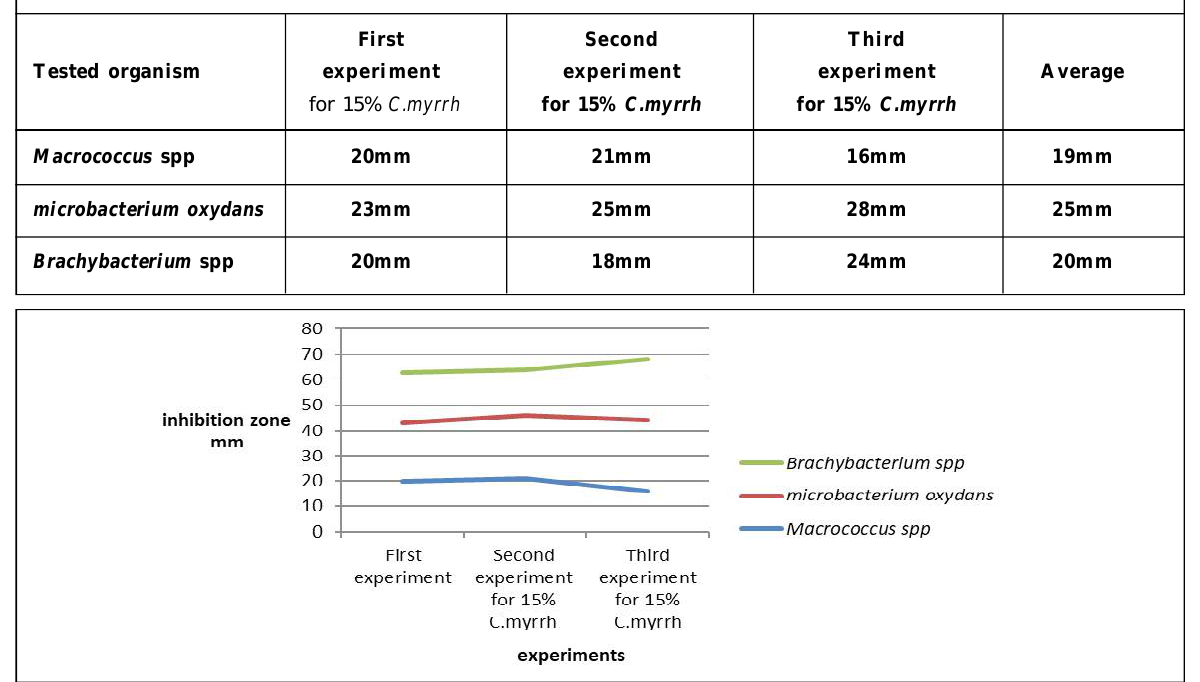
isolatesTable 6: The antimicrobial effect of 15% of C. myrrh extract against microbial isolates. Zone of inhibition measured in mm.